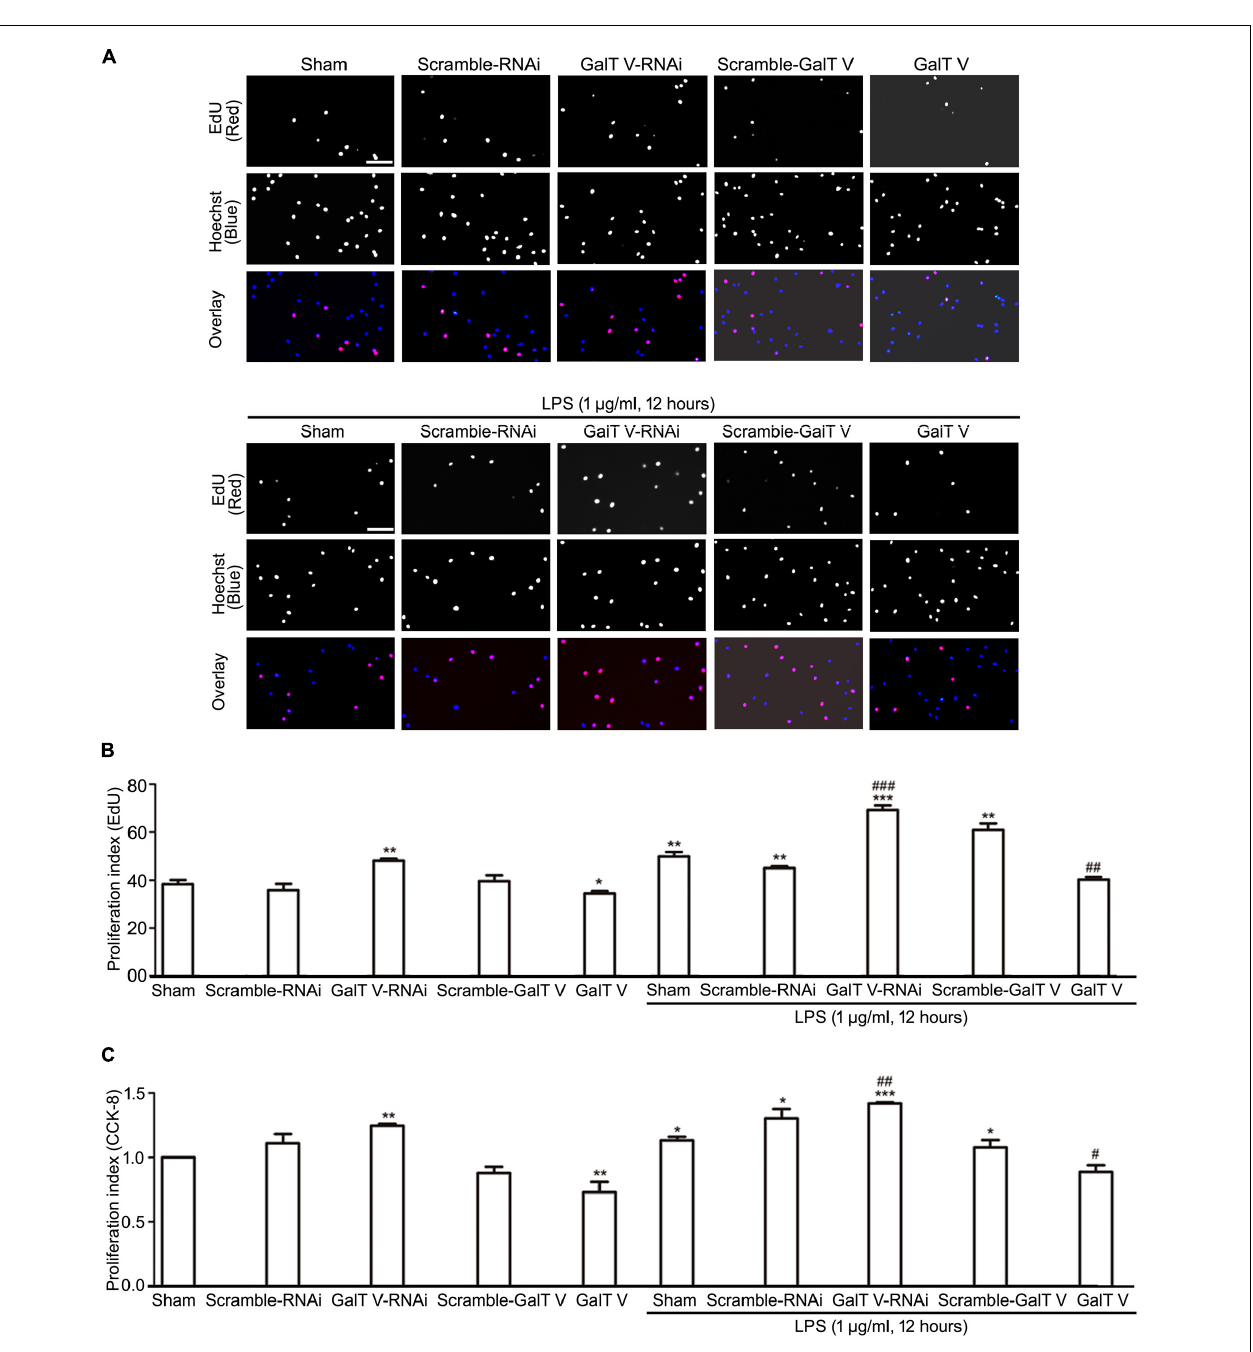
FIGURE 4 | Inhibition of β -1, 4-GalT V on cell proliferation. HAPI cells with designated constructions were treated with LPS (1 µ g/ml, 12 h), as indicated. Proliferation of HAPA cells was detected by EdU assay (A,B) and CCK-8 test (C) . (A) Representative images for DNA replicating cells by red fluorescence in nucleus; scale bar, 100 µ m. (B) Quantification of DNA replicating cells [proliferation index (EdU) = DNA replicating cells/Hoechst positive cells × 100%]. (C) Quantification of cell proliferation by CCK-8 test [proliferation index (CCK-8) = absorbance/absorbance in non-treated sham group]. Groups significantly different from non-treated sham group, LPS-treated sham group were marked by asterisks, hashtags respectively. Graphs show mean ± SD; n = 3; * p < 0.05, ** p < 0.01, *** p < 0.001, # p < 0.05, ## p < 0.01, ### p <